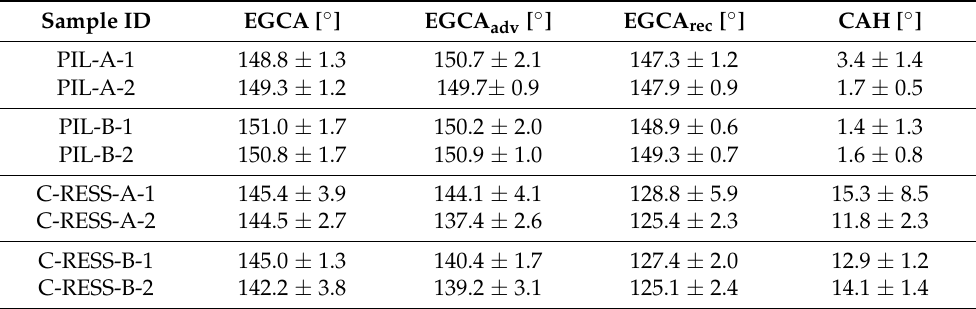
Table 2. Measured ethylene glycol contact angle (EGCA) and its contact angle hysteresis (CAH) of the PIL and C-RESS micro-structures replicated with resin A and resin B on PC foil. Note that for each sample the EGCA was measured on five different locations across the